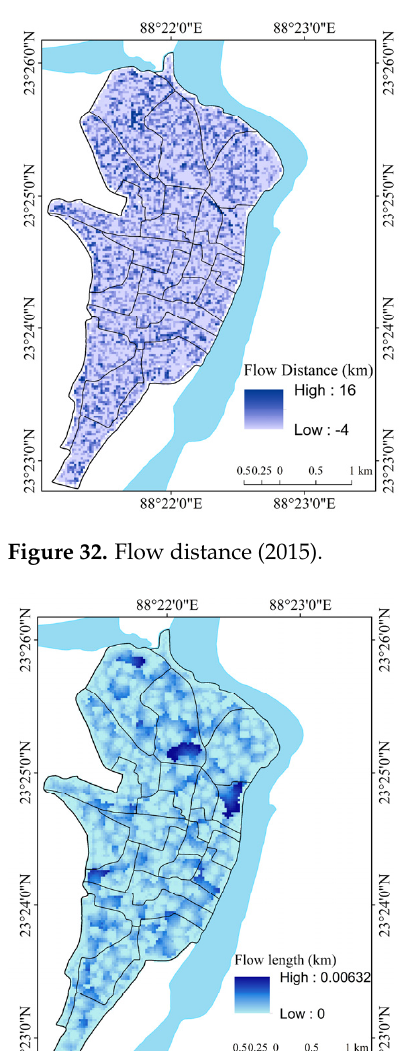
Figure 31. Flow direction (2015).